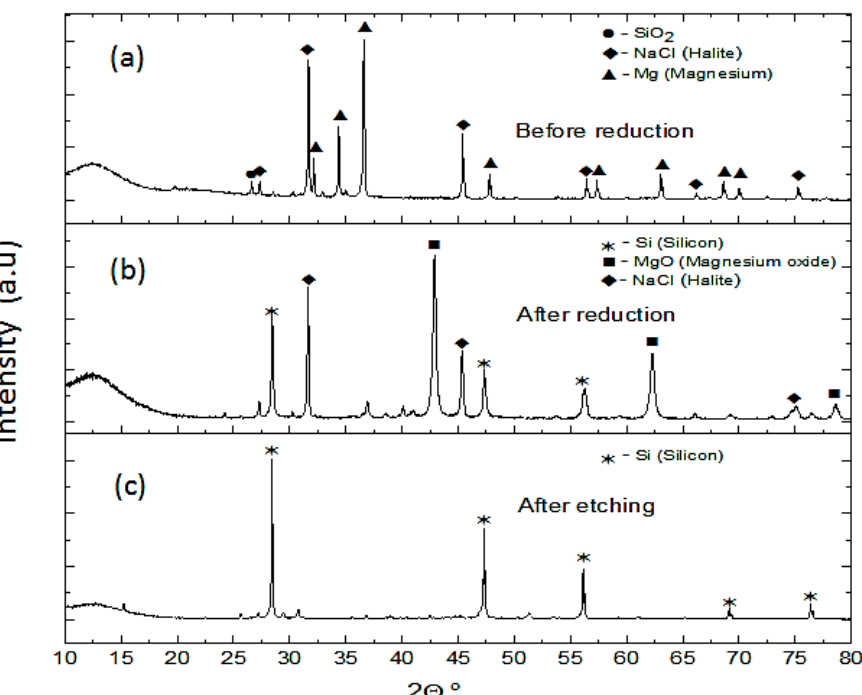
Figure 3. XRD pattern: ( a ) reaction mixture before the metallothermic reduction reaction (MRR), ( b ) remaining loose powder after the MRR, and ( c ) silicon obtained from remaining loose powder after etching.